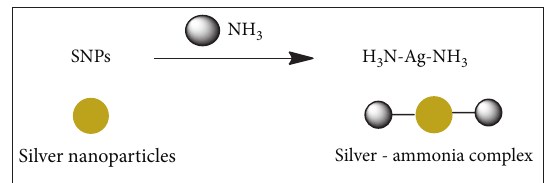
Figure 7: Reaction mechanism of silver nanoparticles with ammonia. Table 1: Determination of ammonia in real sample using the synthesized silver nanoparticles. Type of sample